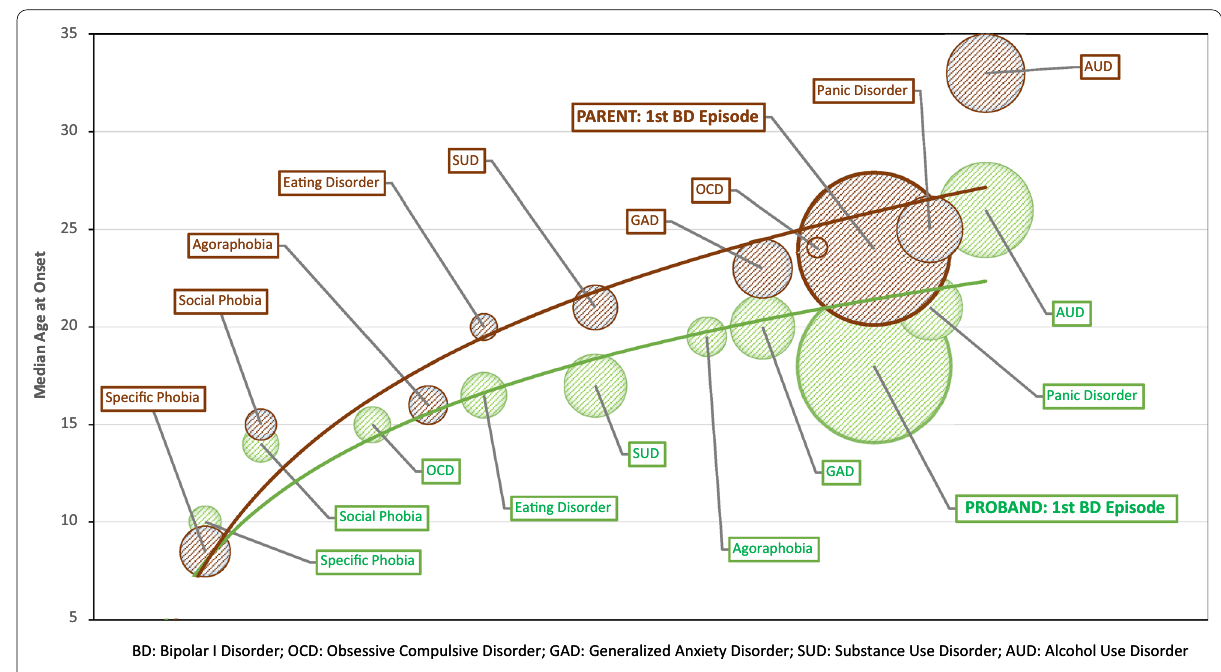
Fig. 2 Trajectories of evolution of BD-I in probands and parents. In the bubble plot, the size of the bubble represents the proportion of the group who experience a particular disorder, the position of the bubble vertically gives the median AAO, whilst the position on the horizontal axis approximates to the timing of onset of a disorder in the interval between the onset of the first full threshold mental disorder and the onset of the last comorbidity. It is notable that the median AAO of the first mental disorder (specific phobia) is similar in the Proband and Parent subgroups, and that the sequence of onset of disorders (except, e.g. OCD) is similar. The size of the bubbles is somewhat similar, but AAOs of comorbidities begin to occur earlier in the Proband subgroup, and median AAO of BD-I is clearly earlier than in the Parent subgroup. Both curves show the fit for the trajectory curve is less for comorbidities that occur post-onset of